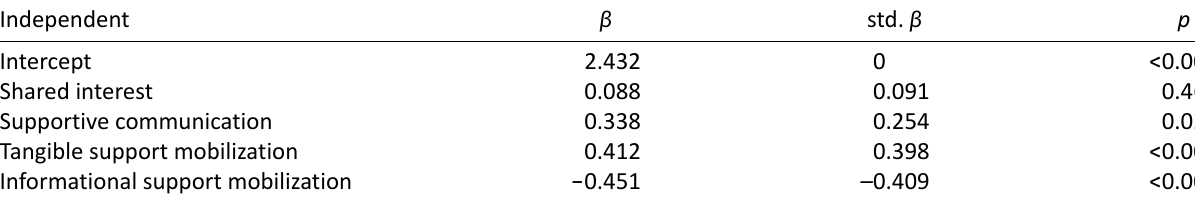
Table 4. Determinant table (regression on perceived neighborhood social support).